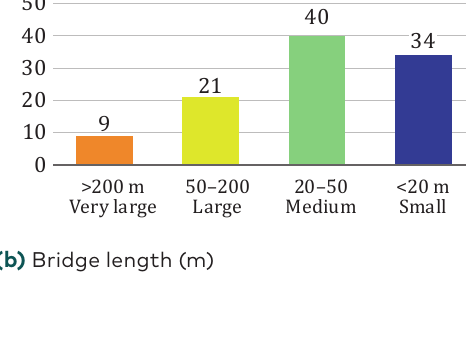
Figure 1. Classification of inspected